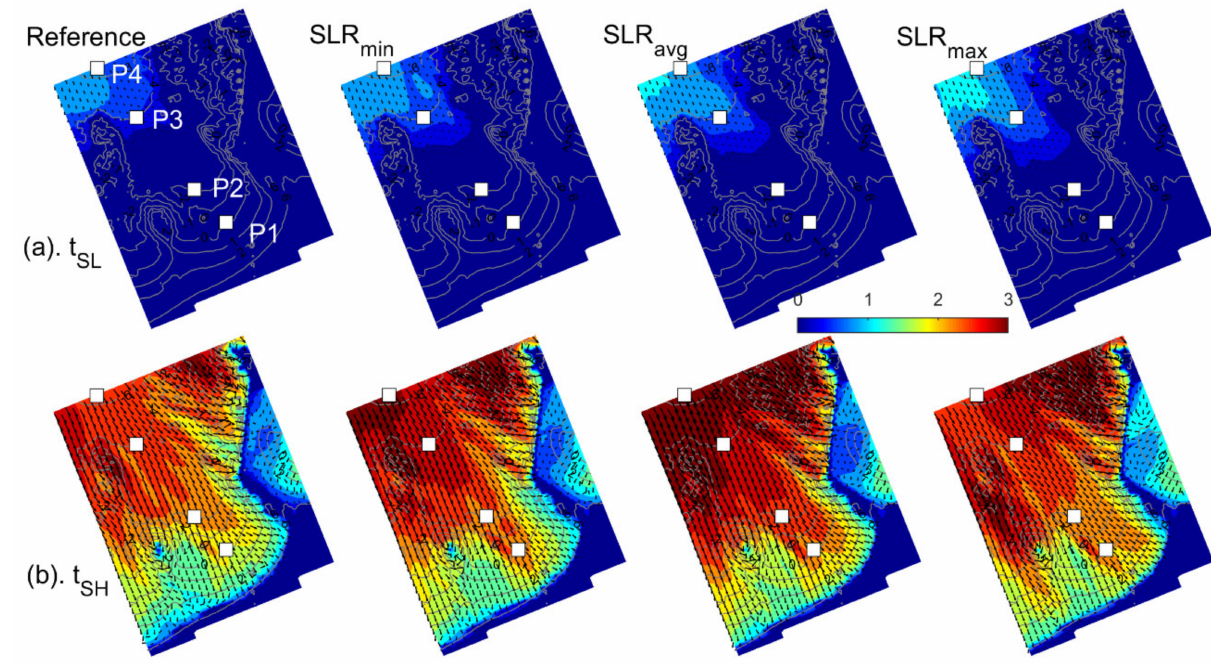
Figure 8. Simulated wave height distributions in the G3 domain for the reference, SLR min , SLR avg , and SLR max scenarios for t SL : spring-low water ( a ) and t SH : spring-high water ( b ), indicating the analysis locations (white squares) P1 (0 m depth), P2 (2 m), P3 (4 m), and P4 (6.5